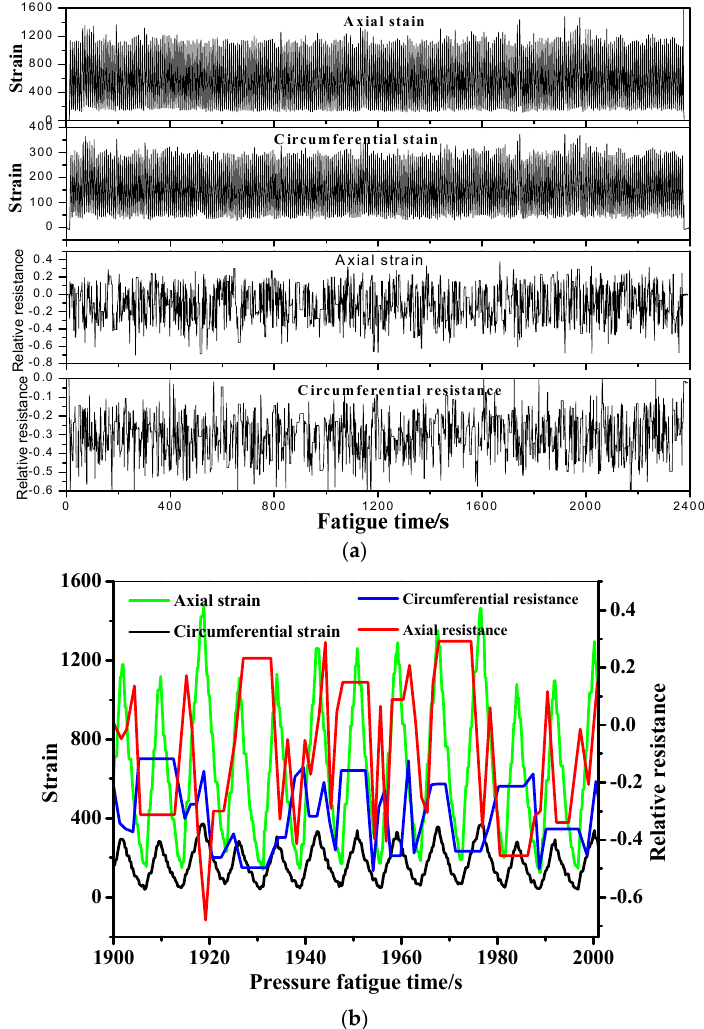
Figure 11. Monitoring results by the MWCNT sensor and the stain gauge when the filament wound pressure vessel is in 2100- to 2400-fatigue cycling. The strain is measured by strain gauge-2 in Figure 4. ( a ) Resistance, the stain as a function of the fatigue time. ( b ) The enlarged drawing curves.